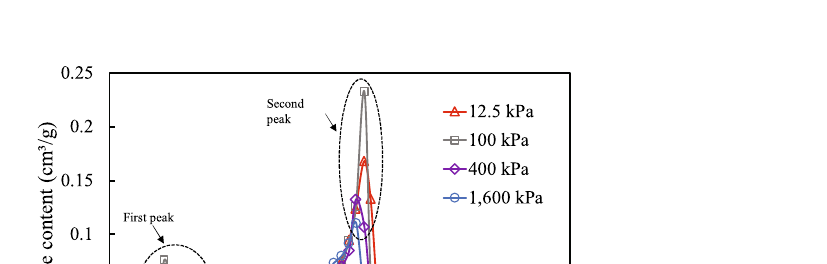
Figure 9. Relationship between aperture and cumulative pore volume.